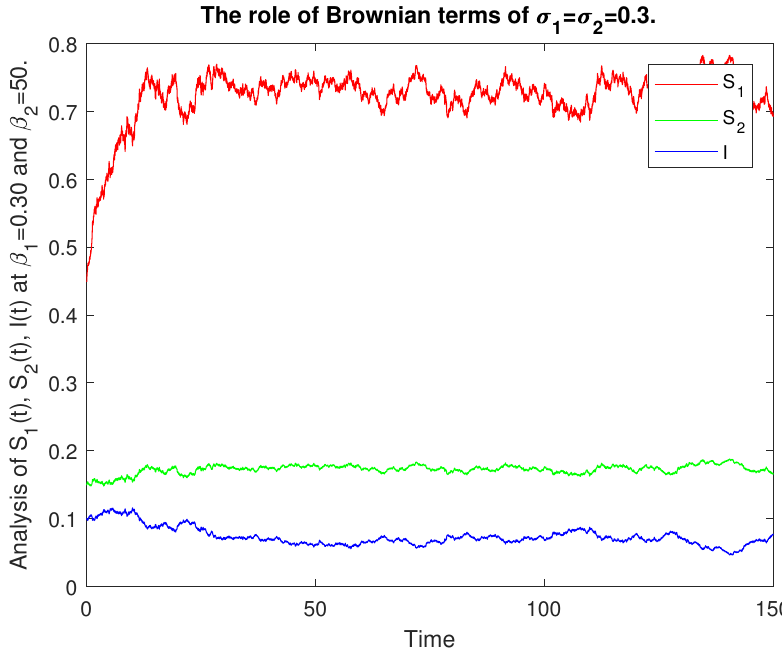
Figure 10. Comparative analysis of S 1 ( t ) , S 2 ( t ) , I ( t ) for β 1 = 0.30, β 2 = 0.50.